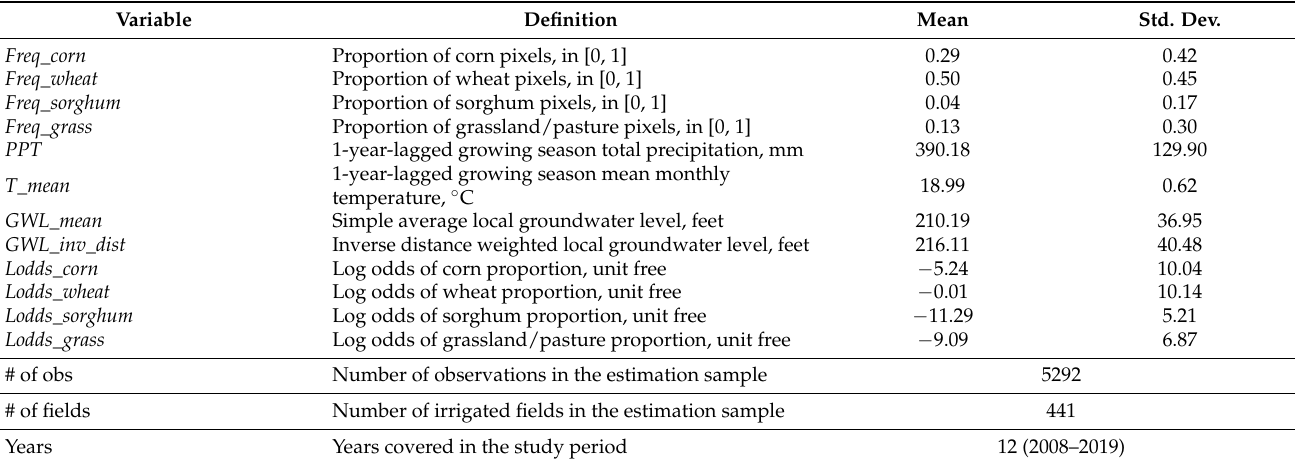
Table 1. Summary statistics and variable